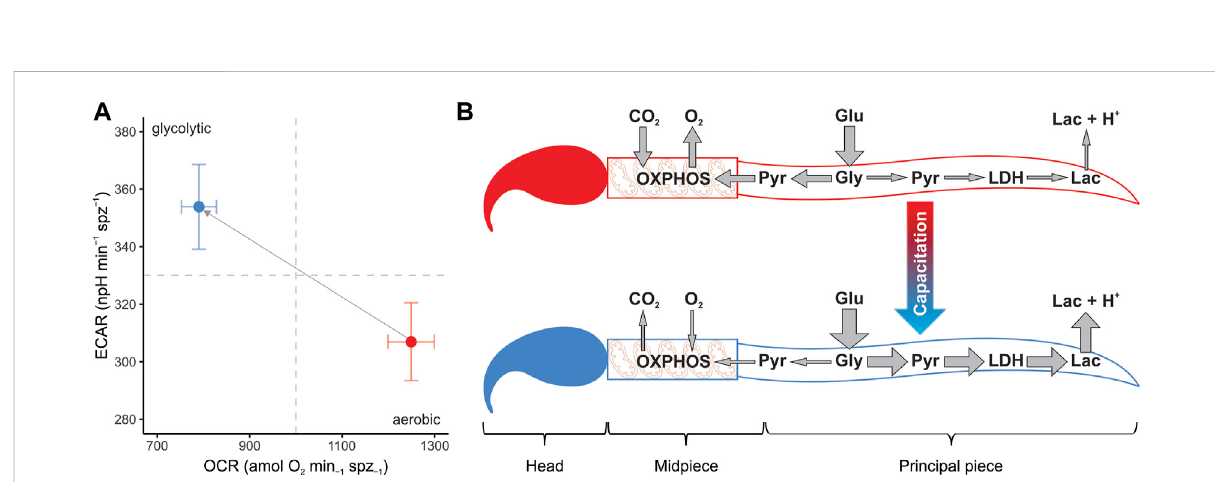
FIGURE 7 Changes in metabolic phenotype promoted by sperm capacitation in murine sperm. (A) Metabolic phenotype plot of mouse sperm depicting the usage of the two main metabolic pathways (OXPHOS and anaerobic glycolysis). Symbols and whiskers correspond to means ± standard error. Red symbols: non-capacitating conditions. Blue symbols: capacitating conditions. Dashed grey lines indicate the midpoint in the measurement range for both variables. (B) Graphical depiction of conclusions. Capacitation promotes a metabolic shift in the mouse sperm, increasing the uptake of glucose and altering the proportion of pyruvate that enters each metabolic pathway. A greater proportion of pyruvate is reduced into lactate by the enzyme lactate dehydrogenase and transported to the extracellular environment along with protons, while a relatively minor proportion is transported to the mitochondria in the midpiece, thereby entering the OXPHOS pathway. Lac: lactate. LDH: lactate dehydrogenase. Pyr: pyruvate. Gly: glycolysis. Glu: